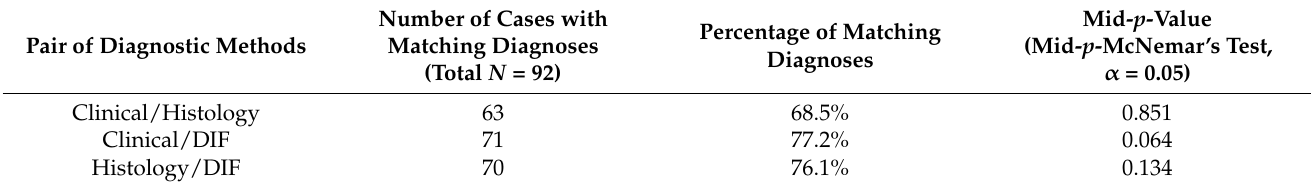
Table 5. Differences Between the Paired Diagnostic Methods Of Autoimmune Bullous